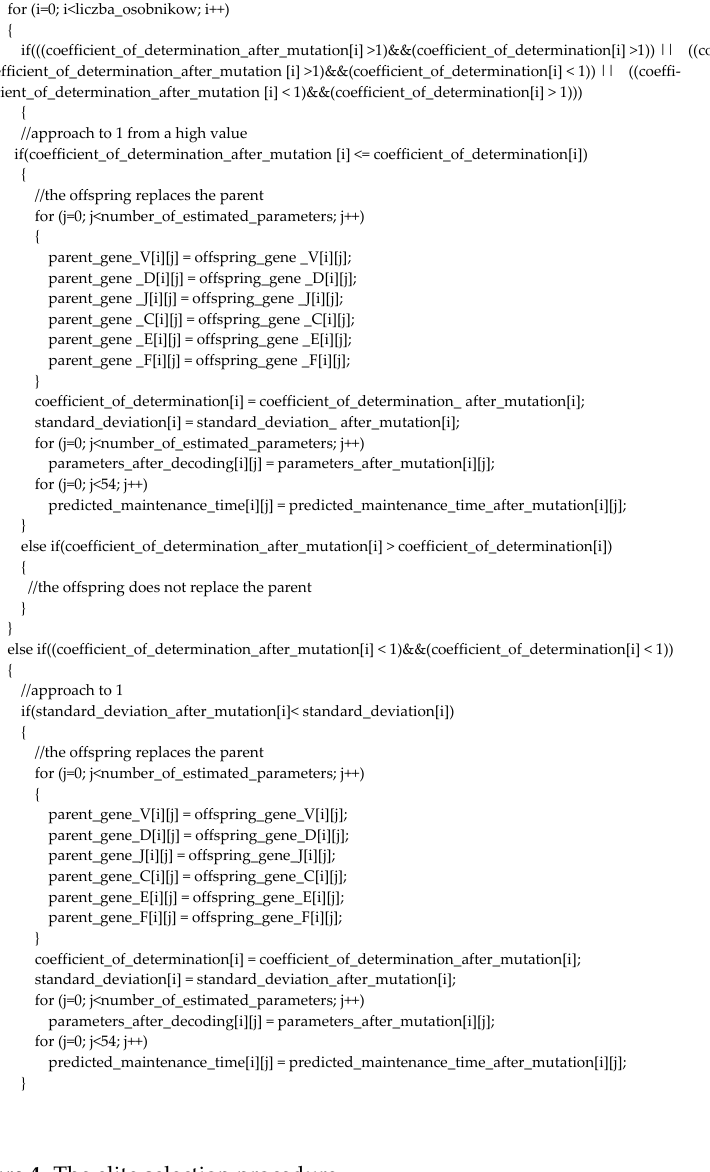
Figure 4. The elite selection